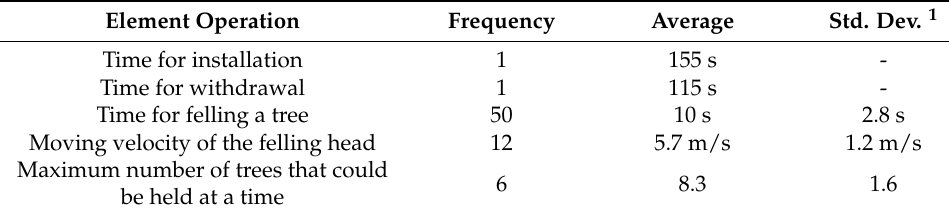
Table 3. Results of the time study.